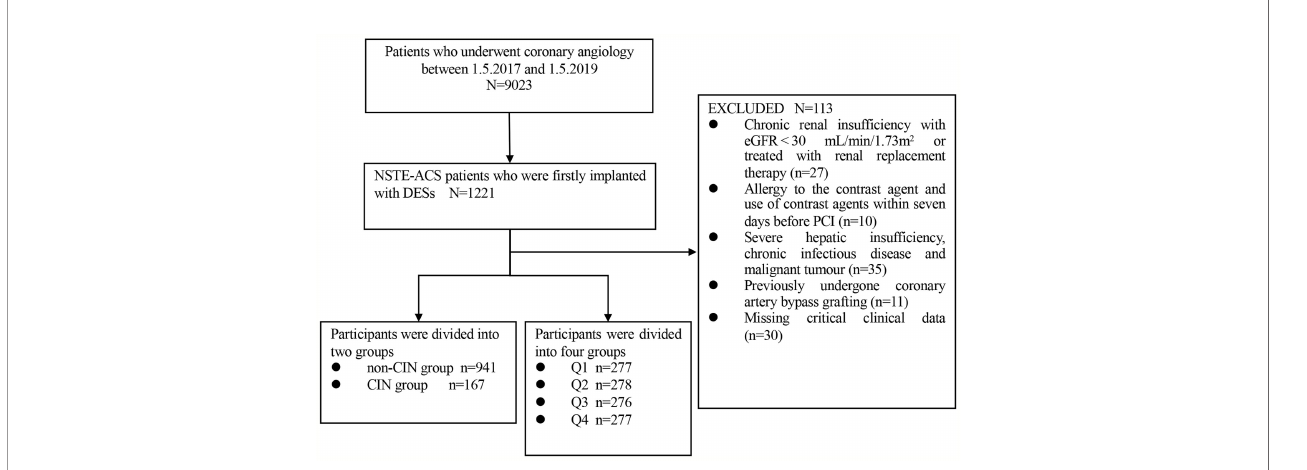
FIGURE 1 | Flow diagram of